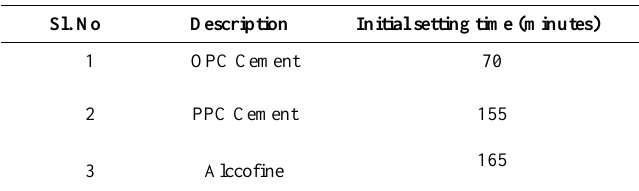
Table 5. Initial setting time.